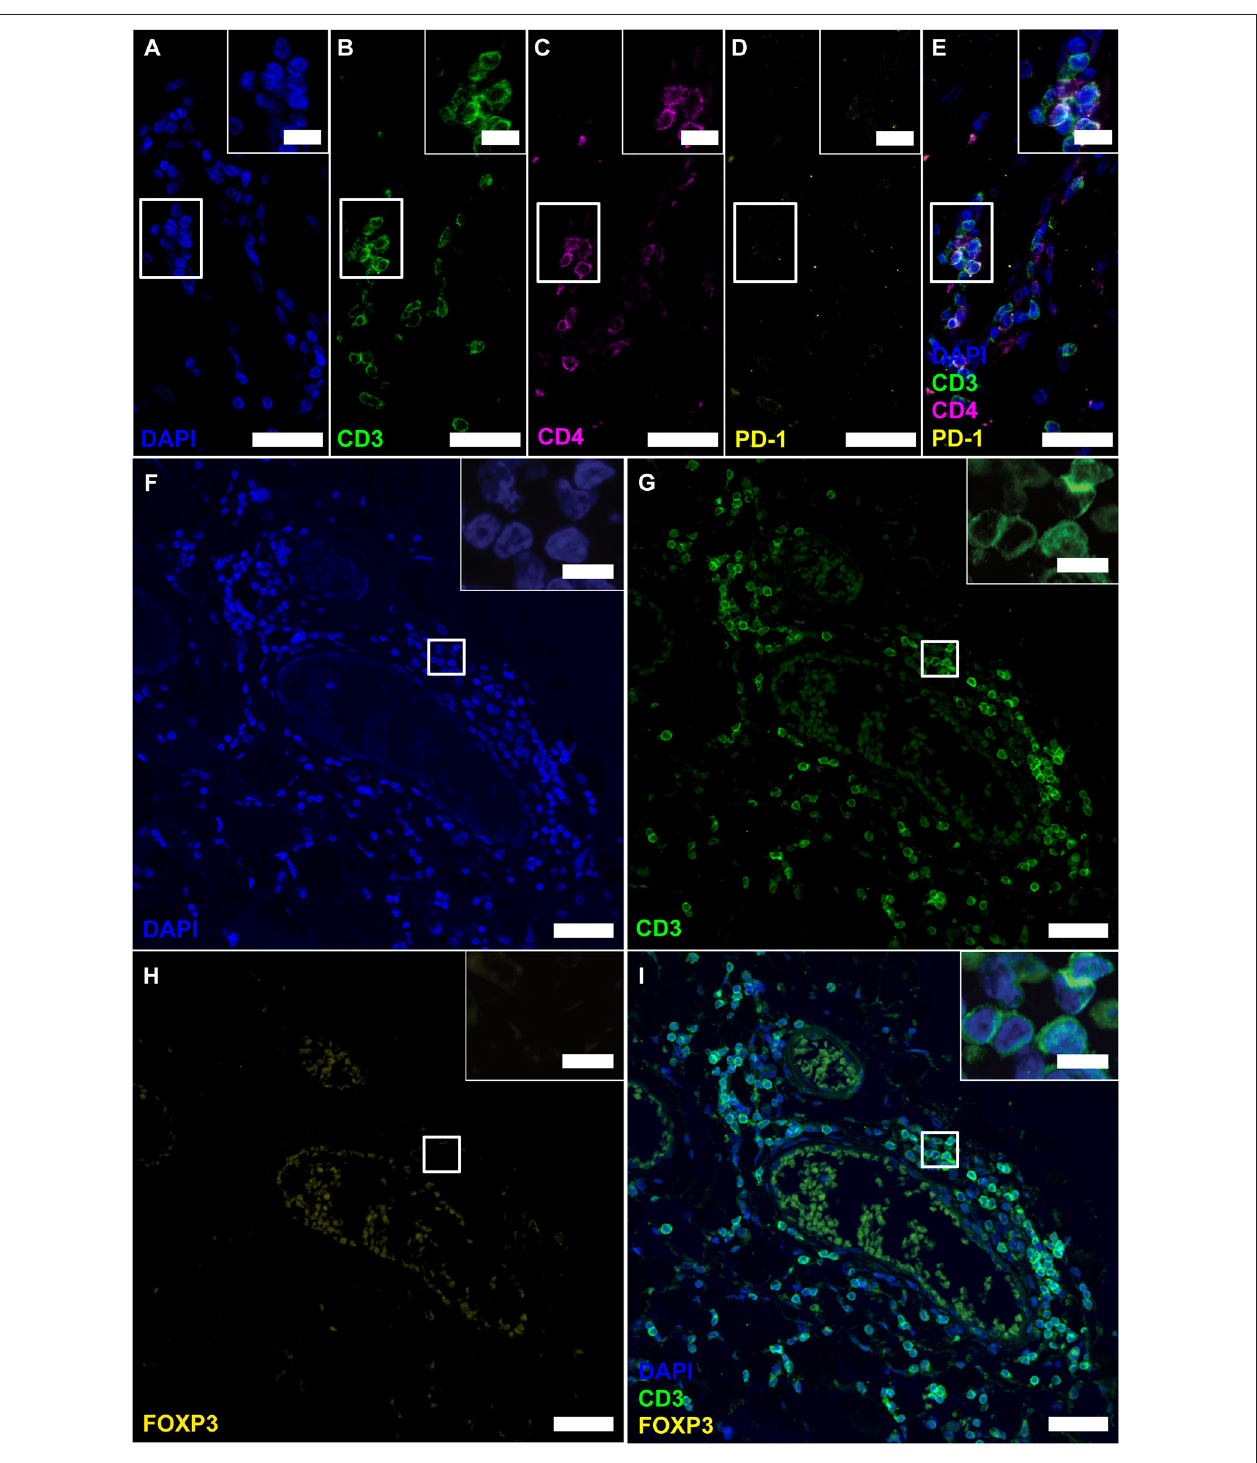
FIGURE 4 | Follicle-like structures of SPMS brains exhibit CD3 + CD4 + T cells, which neither express PD-1 nor FOXP3. (A–E) IF staining of CD3, CD4 and PD-1 reveal CD3 + CD4 + PD-1 − T-helper cells in progressive MS. Inserts in the upper right corners show magnification of the white box. (F–I) IF staining of CD3 and FOXP3 on serial sections of a representative meningeal follicle-like structure in SPMS (same region as Figure 3 ). CD3 + T cells, but no FOXP3 + cells were detected. Inserts show magnification of the white box. Scale bars indicate 100 µ m, inserts 10 µ m.